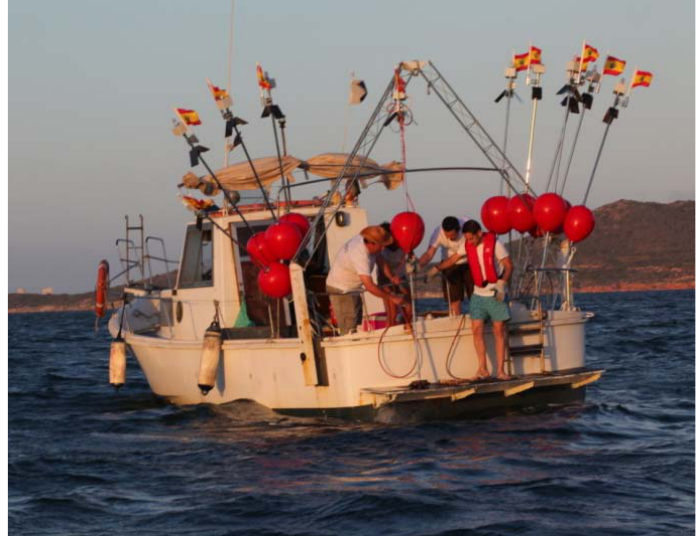
Figure 9. The boat used for the deployment trials in the Mar